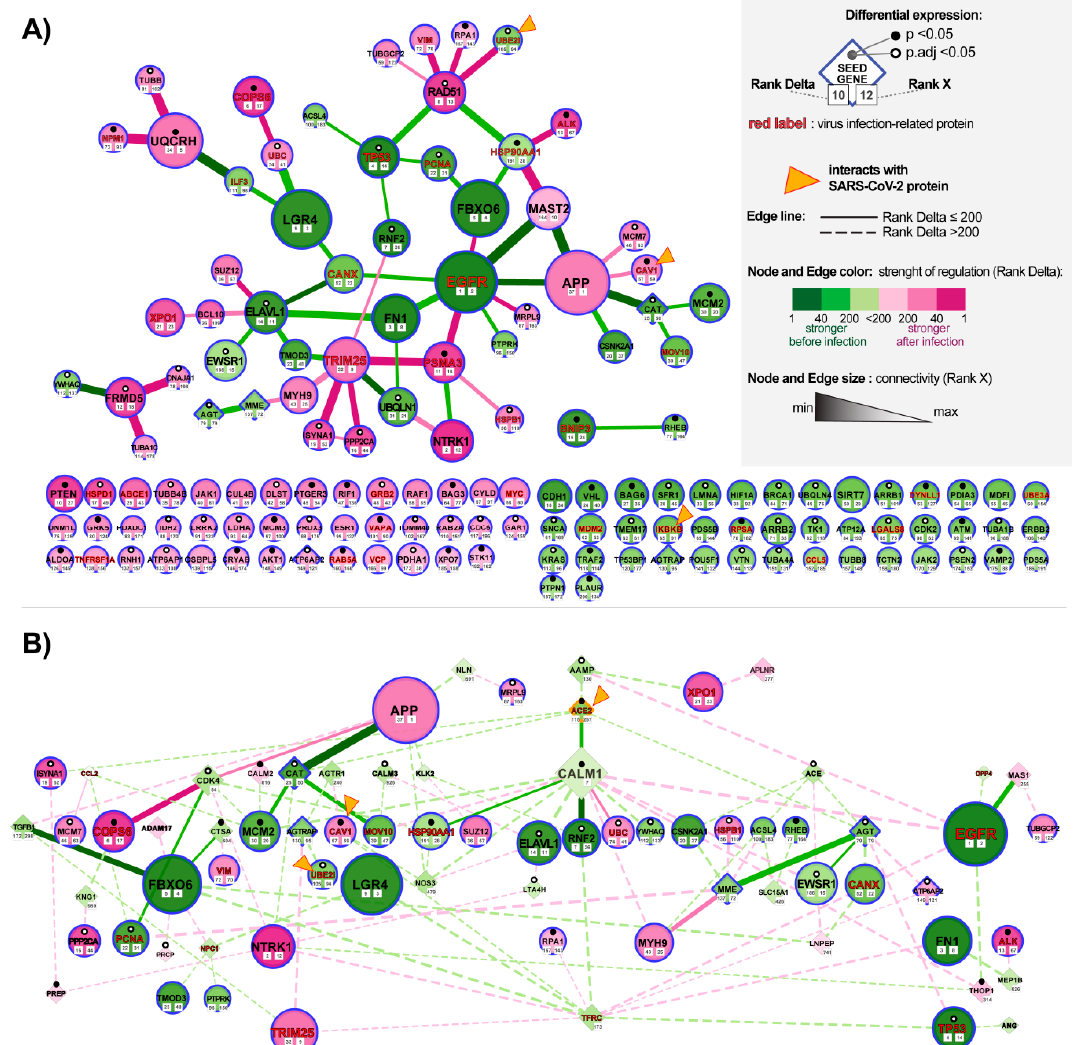
Figure 4. Alteration of ACE2 (Angiotensin-Converting Enzyme 2) networks in cardiomyocytes infected with SARS-CoV-2. ( A ) ACE-2 related hub genes with corroborated signaling obtained by analyzing expression data of human-induced pluripotent stem cell-derived cardiomyocytes (hiPSC-CMs) after 72 h of infection with SARS-CoV2. The network was constructed by using the NERI (Network by Relative Importance) algorithm which integrates protein-protein interaction (PPI) BioGrid interactome with gene co-expression network. For clarity, we selected top genes and edges which had Rank Delta and Rank S number between 1 and 200; additionally, we showed nodes with the best NERI scores (low-rank number) which did not have associated edges with best scores (low-rank number). Genes marked with orange triangles showed direct interaction with SARS-Cov-2 [39]. Notice that EGFR (Epidermal Growth Factor Receptor) and APP (Amyloid Beta Precursor Protein) showed the strongest alterations in their co-expression networks. ( B ) PPI network between top co-expressed hub genes from panel A (circular shapes) and seed genes (diamond shapes) related to the complete ACE2 network identified using data mining. The size of the nodes and weight of the edges is associated with Rank X number, related to biological importance, while color is associated with Rank Delta, related to the difference in co-expression network between control and disease. Notice that ACE2 shows a reduced number of connections, consistent with its initial downregulation in the early stage of infection; in later stages of infection, we can expect an inversion of observed regulation caused by the virus-related ACE2 overexpression